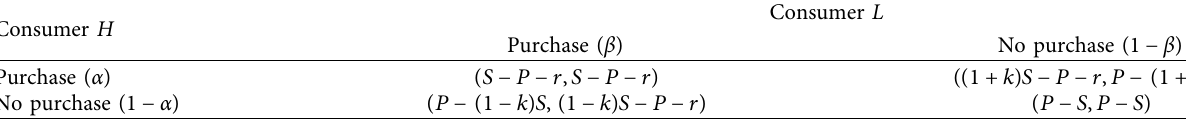
Table 1: The payoff matrix of consumers H and L